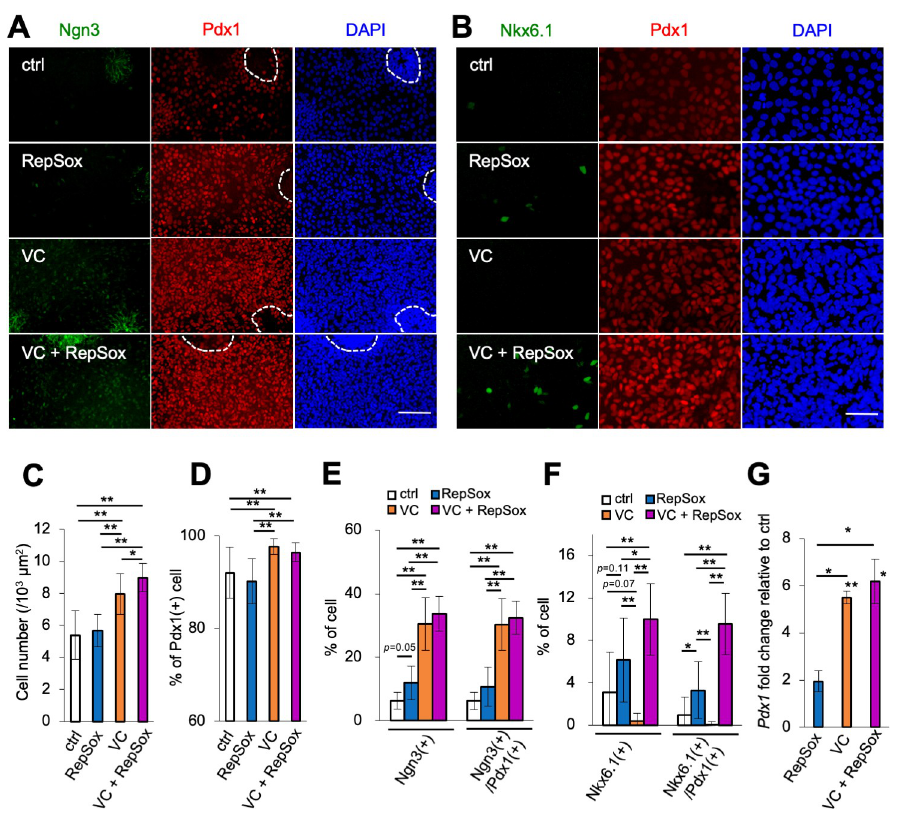
Fig 3. Addition of vitamin C or RepSox increased the rate of differentiation into pancreatic progenitor cells (stage 3). ( A, B ) IHC for Ngn3 (green) and Pdx1 (red) ( A ) and for Nkx6.1 (green) and Pdx1 (red) ( B ) at stage 3. DAPI staining shown in blue. Circle with a dashed line in A shows the mass region. Scale bars: 100 μ m ( A ), 50 μ m ( B ). ( C ) Cell number in the monolayer region, measured by DAPI-stained images: control, white; RepSox, blue; VC (vitamin C-treated), orange; VC (vitamin C-treated) + RepSox, magenta (n = 15, including five biological and three technical replicates). � p < 0.05, �� p < 0.01; Welch’s t -test. ( D-F ) Percentage of cells expressing the indicated differentiation markers in 0.029 mm 2 foci from the monolayer region using IHC results: control (no VC and no RepSox), white; RepSox, blue; VC, orange; VC + RepSox, magenta. Percentage of Pdx1(+) cells (n = 15, including five biological and three technical replicates) ( D ). Percentage of cells of Ngn3(+) and Ngn3(+)/Pdx1(+) (n = 6, including two biological and three technical replicates) ( E ). Percentage of cells of Nkx6.1(+) and Nkx6.1(+)/Pdx1(+) (n = 9, including three biological and three technical replicates) ( F ). Horizontal bars indicate statistical analysis in E, F . � p < 0.05, �� p < 0.01; Welch’s t -test. ( G ) Fold change expression level of Pdx1 compared with the control at stage 3: RepSox, blue; VC, orange; VC + RepSox, magenta (three biological replicates per group) by qRT-PCR (normalized against the control (no vitamin C and no RepSox)). � p < 0.05, �� p < 0.01; paired t -test. The asterisk shows a significant difference compared with the